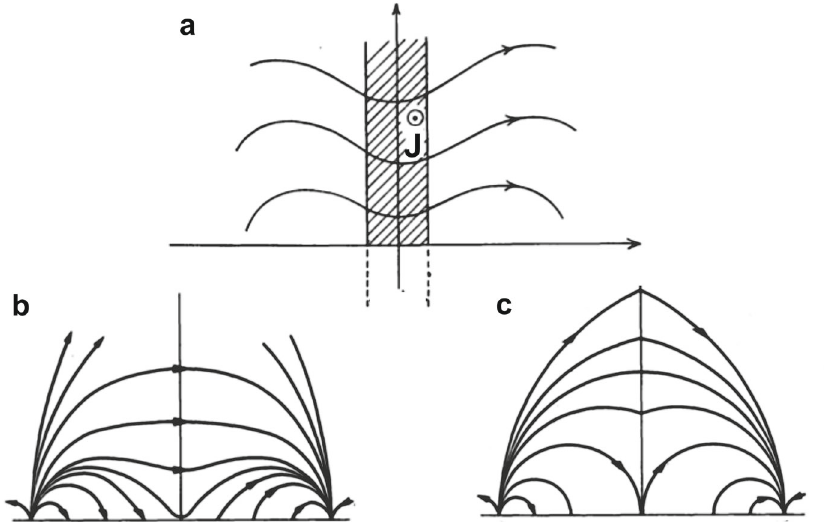
Fig. 2 Cross sections of 2.5D arcade-type prominence models. a Summary representation of Kippenhahn and Schlüter concept (note, current is pointing out of the page.) Image reproduced with permission from Anzer (1969), copyright by D. Reidel. b Example of analytic quadrupolar potential configuration with dips suitable for the formation of a stable prominence, that c may evolve to a non-potential configuration where prominence mass is supported by forces associated with a current sheet at the center of the dips. Image reproduced with permission from Kippenhahn and Schlüter (1957), copyright by